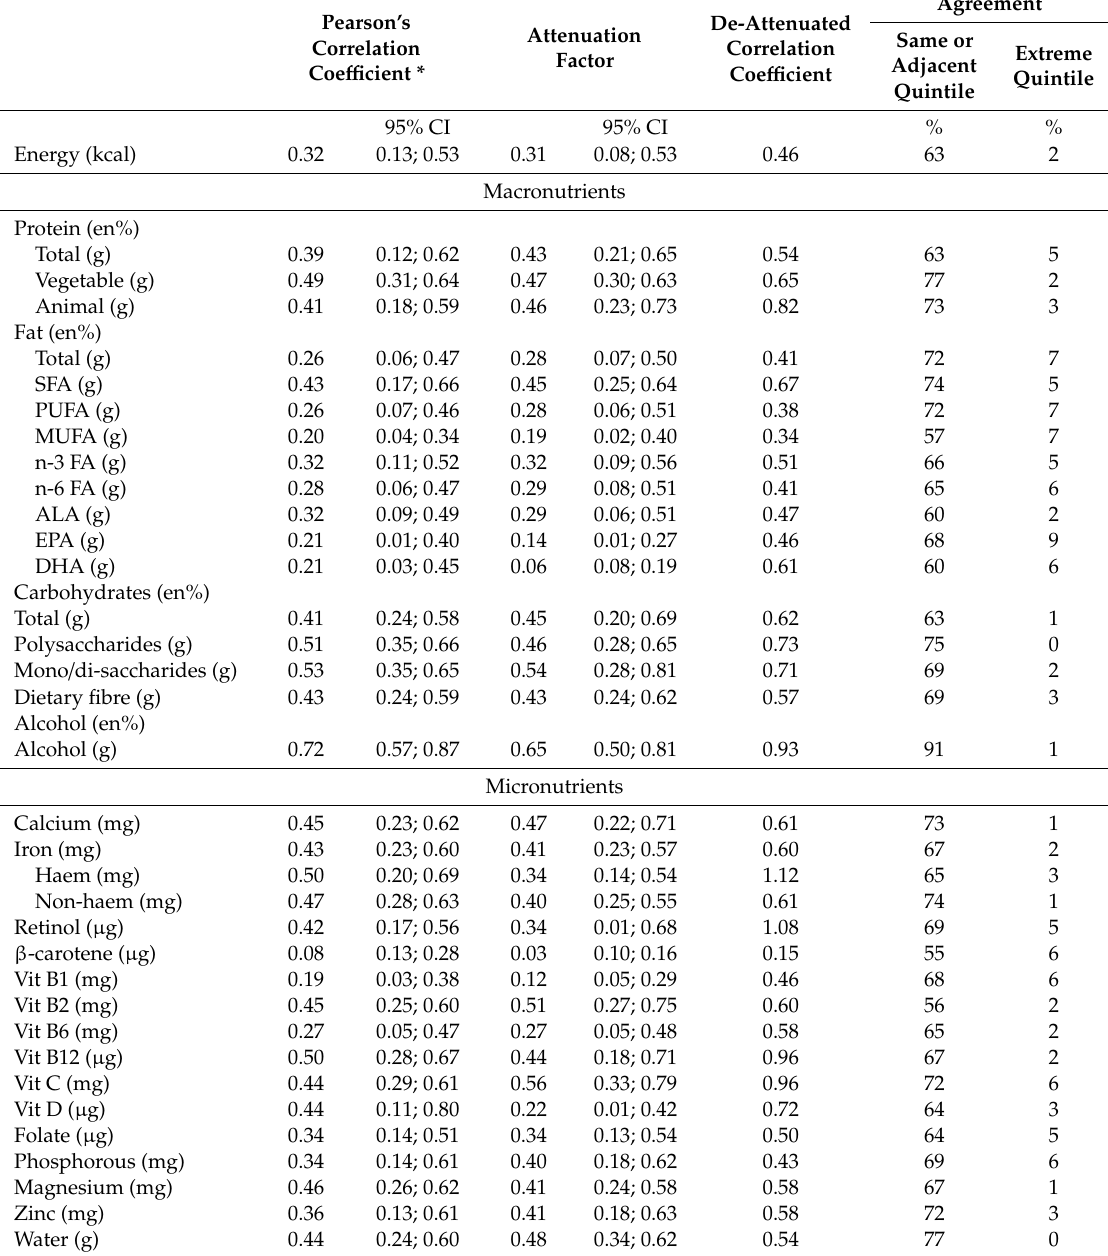
Table 3. Pearson’s correlation coe ffi cient, attenuation factor, and de-attenuated correlation coe ffi cient of energy, nutrients, and food groups intake between the food frequency questionnaire and three 24-hour dietary recalls and agreement between the two methods based on quintiles of energy, nutrient, and food group intake in the 88 validation study participants of the Longitudinal Aging Study